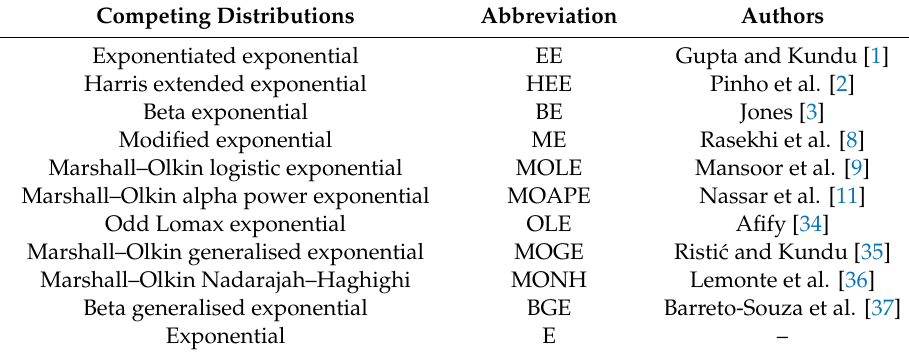
Table 2. Competing distributions of the OEHLE model.